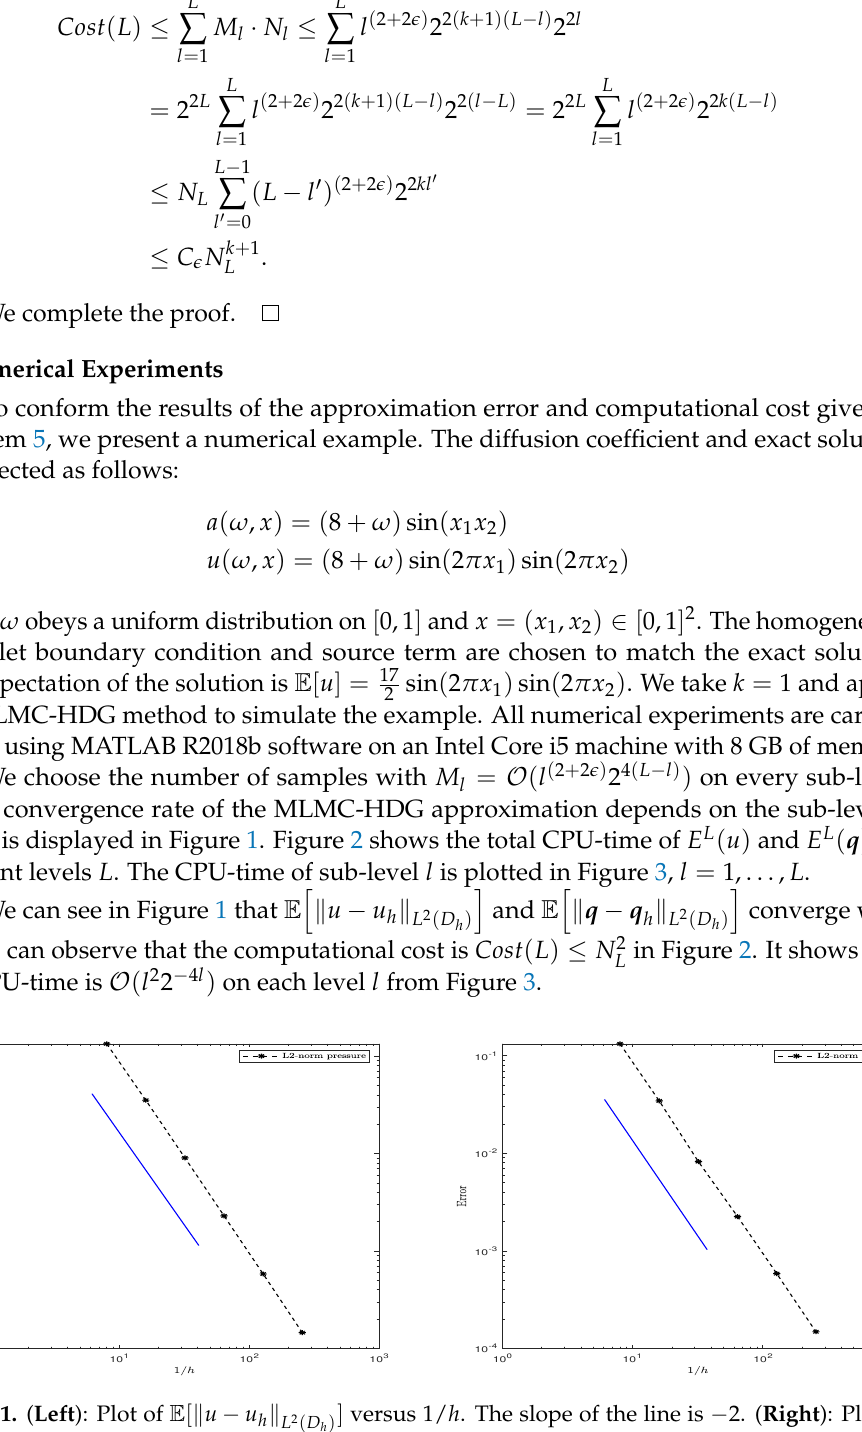
Figure 1. ( Left ): Plot of E [ (cid:107) u − u h (cid:107) E [ (cid:107) q − q ] . The slope of the line is − (cid:107) h L 2 ( D h )